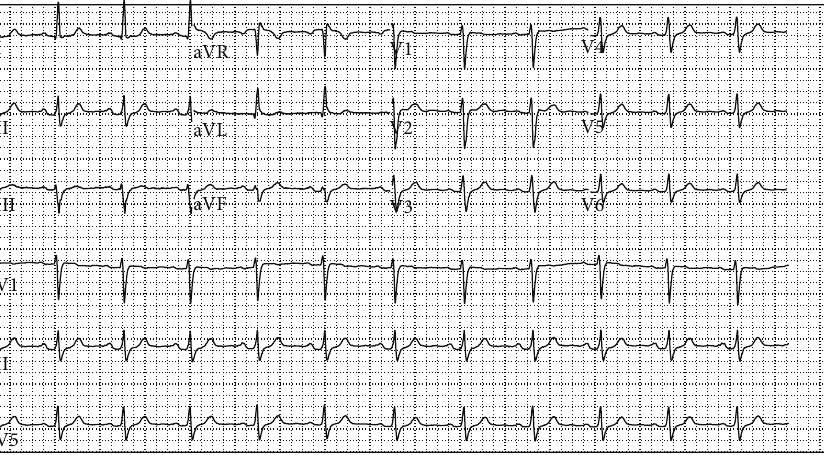
Figure 1: ECG at presentation.